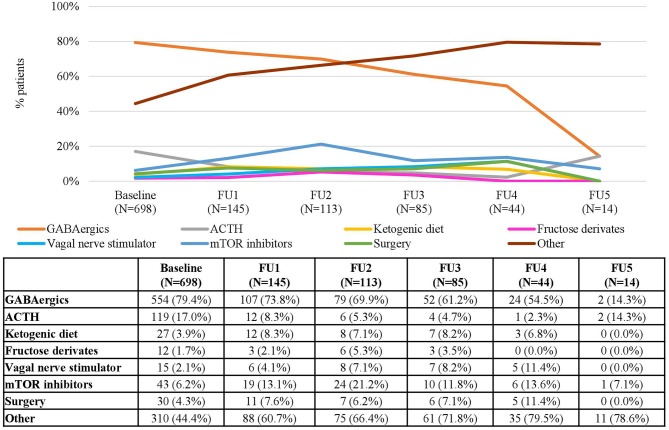
Treatments for Infantile Spasms in each Follow-up Visit. Patients may receive more than one treatment. Baseline data refers to patients who “ever had” the manifestation. Other include lamotrigine, topiramate, levetiracetam and valproate.